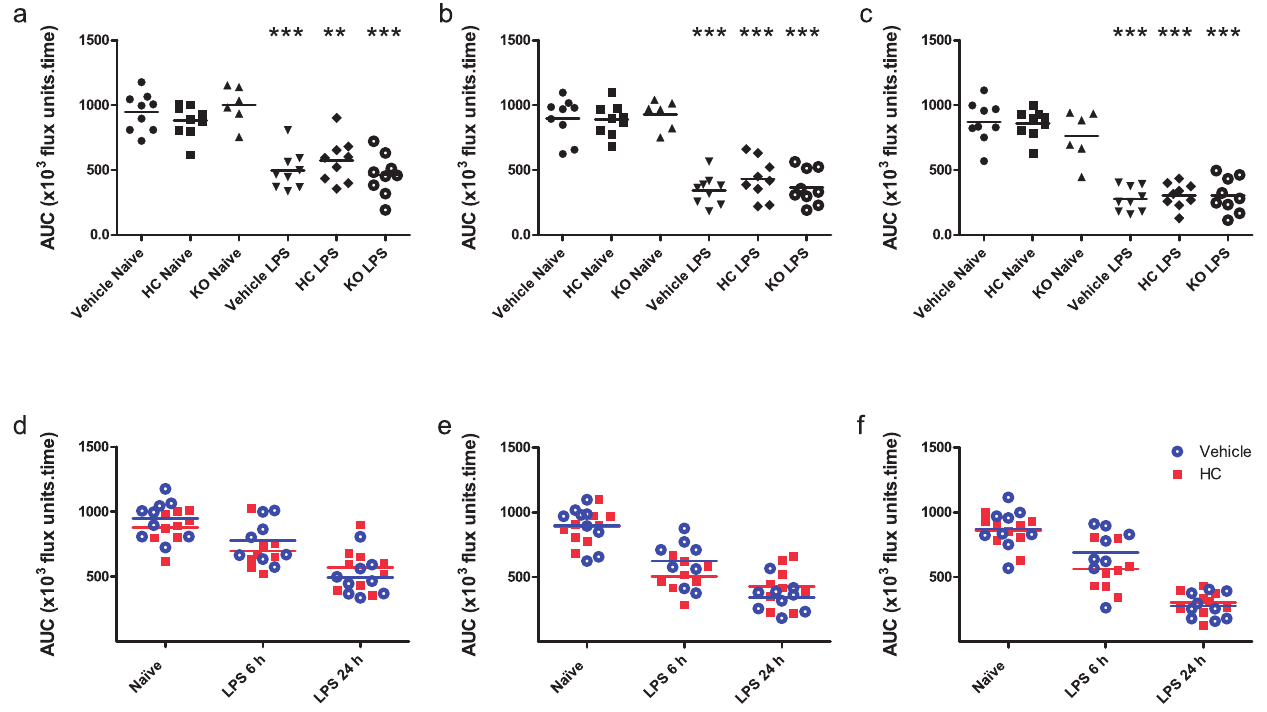
Figure 4. Mesenteric blood flow in healthy and endotoxaemic TRPV4 WT and KO mice. ( a – c ) Mesenteric blood flow in TRPV4 KO mice and WT mice treated i.p. with vehicle (10% DMSO) or HC-067047 (HC) for 24 h, either under naïve or endotoxaemic (LPS 12.5 mg/kg, i.v., 24 h) conditions. Data are expressed as total area under the curve (AUC; ×10 3 flux units.time) over 5-min baseline recording in 1 st , 2 nd and 3 rd order vessels, respectively. **p<0.01, ***p<0.001, relative to naïve counterparts, 1-way ANOVA + Bonferroni post-hoc test. ( d – f ) Mesenteric blood flow in WT mice treated i.p. with vehicle (10% DMSO) or HC-067047, either under naïve (24-h treatment) or endotoxaemic conditions (6 h or 24 h; drugs administered simultaneously with LPS) in 1 st , 2 nd and 3 rd order vessels, respectively. AUC for each animal is